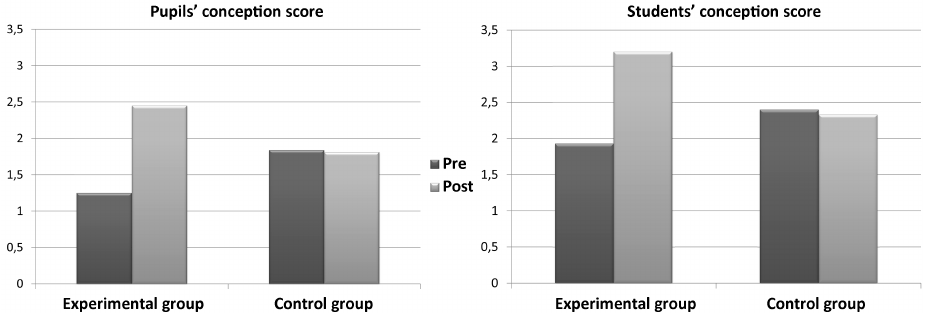
Figure 9. Comparison of the conception scores of the experimental and control groups ( n pupils = 195; n students = 92; max. 4 points).